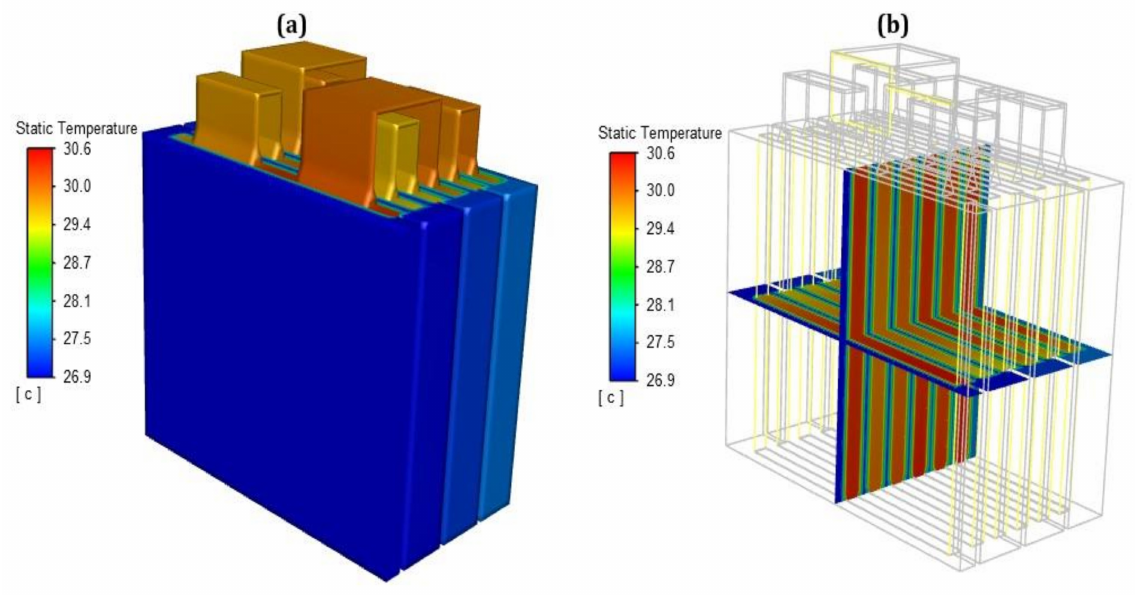
Figure 10. LIB module temperature characteristics at 3C discharge rates with 3M Novec cooling, showing ( a ) full system temperature distribution and ( b ) cell cross-sectional temperature